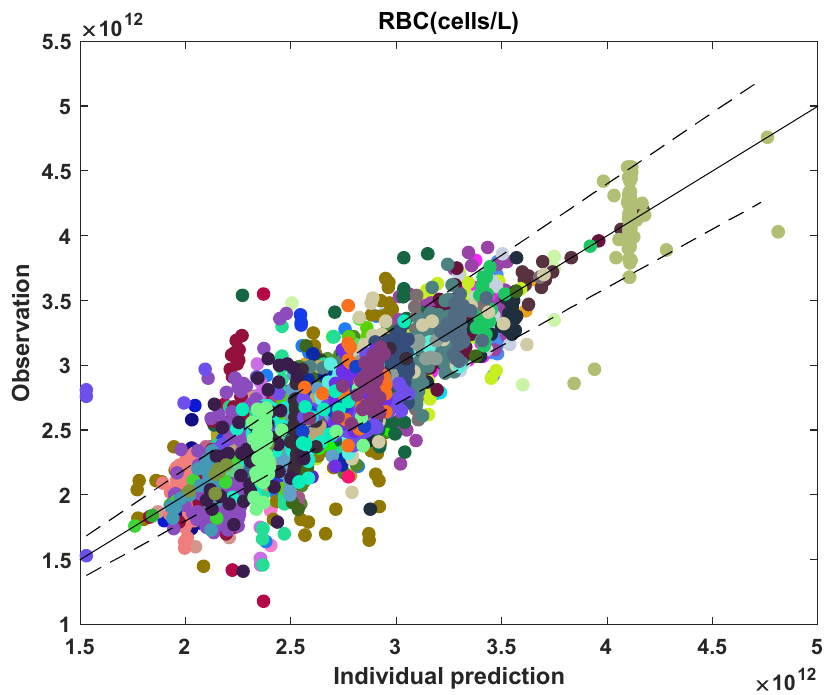
Figure 14. Observation versus individual prediction of RBC for all data points across the population. Each color marks an individual participant. The solid line represents y = x; the dashed lines represent 10% error. Table 3. RBC and MCV model parameter estimates for HUSTLE participants.